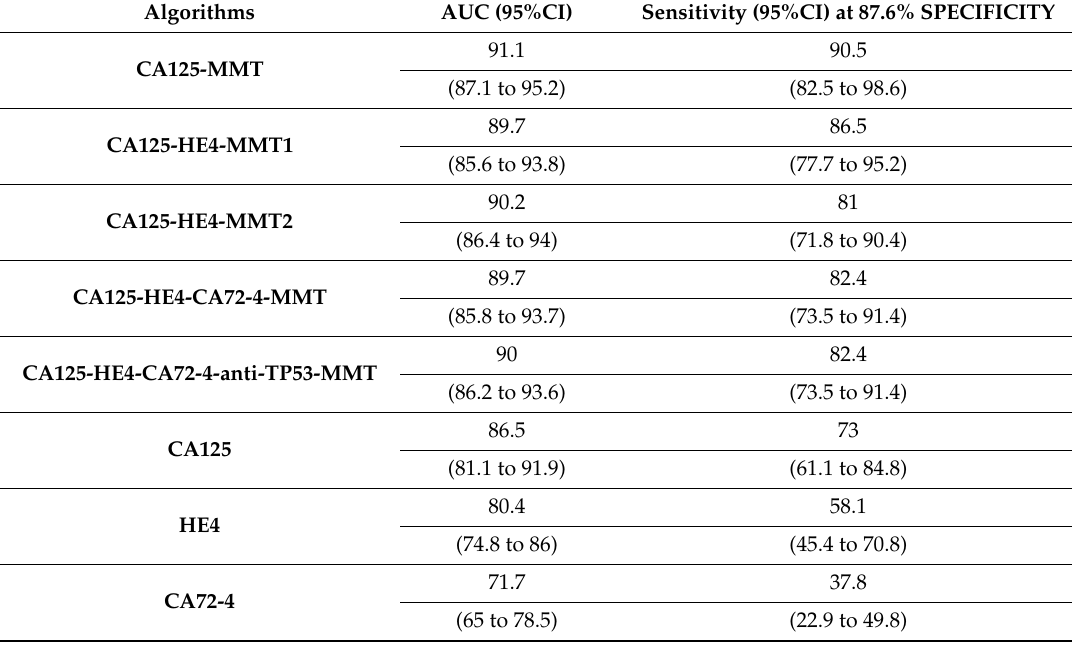
Table 3. Sensitivity and area under the ROC curve (AUC) of algorithms for the detection of invasive tubo-ovarian cancer diagnosed within one year of sample in the validation set.